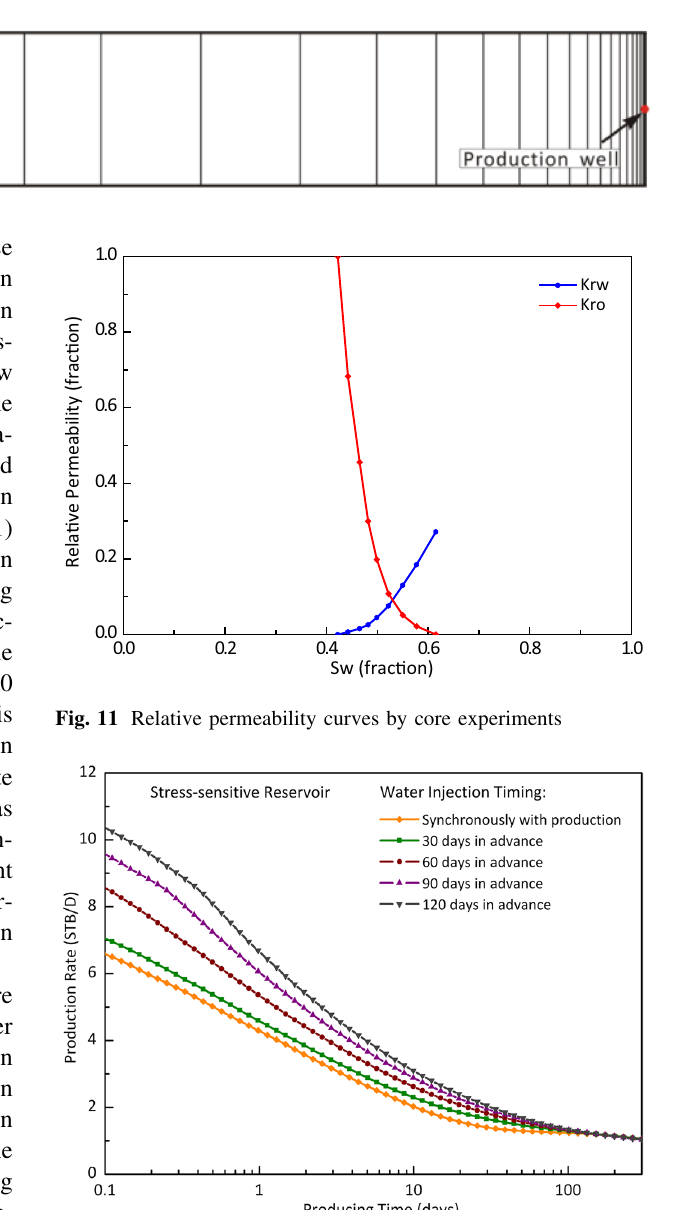
Fig. 12 Oil production rates of waterflooding under different water injection